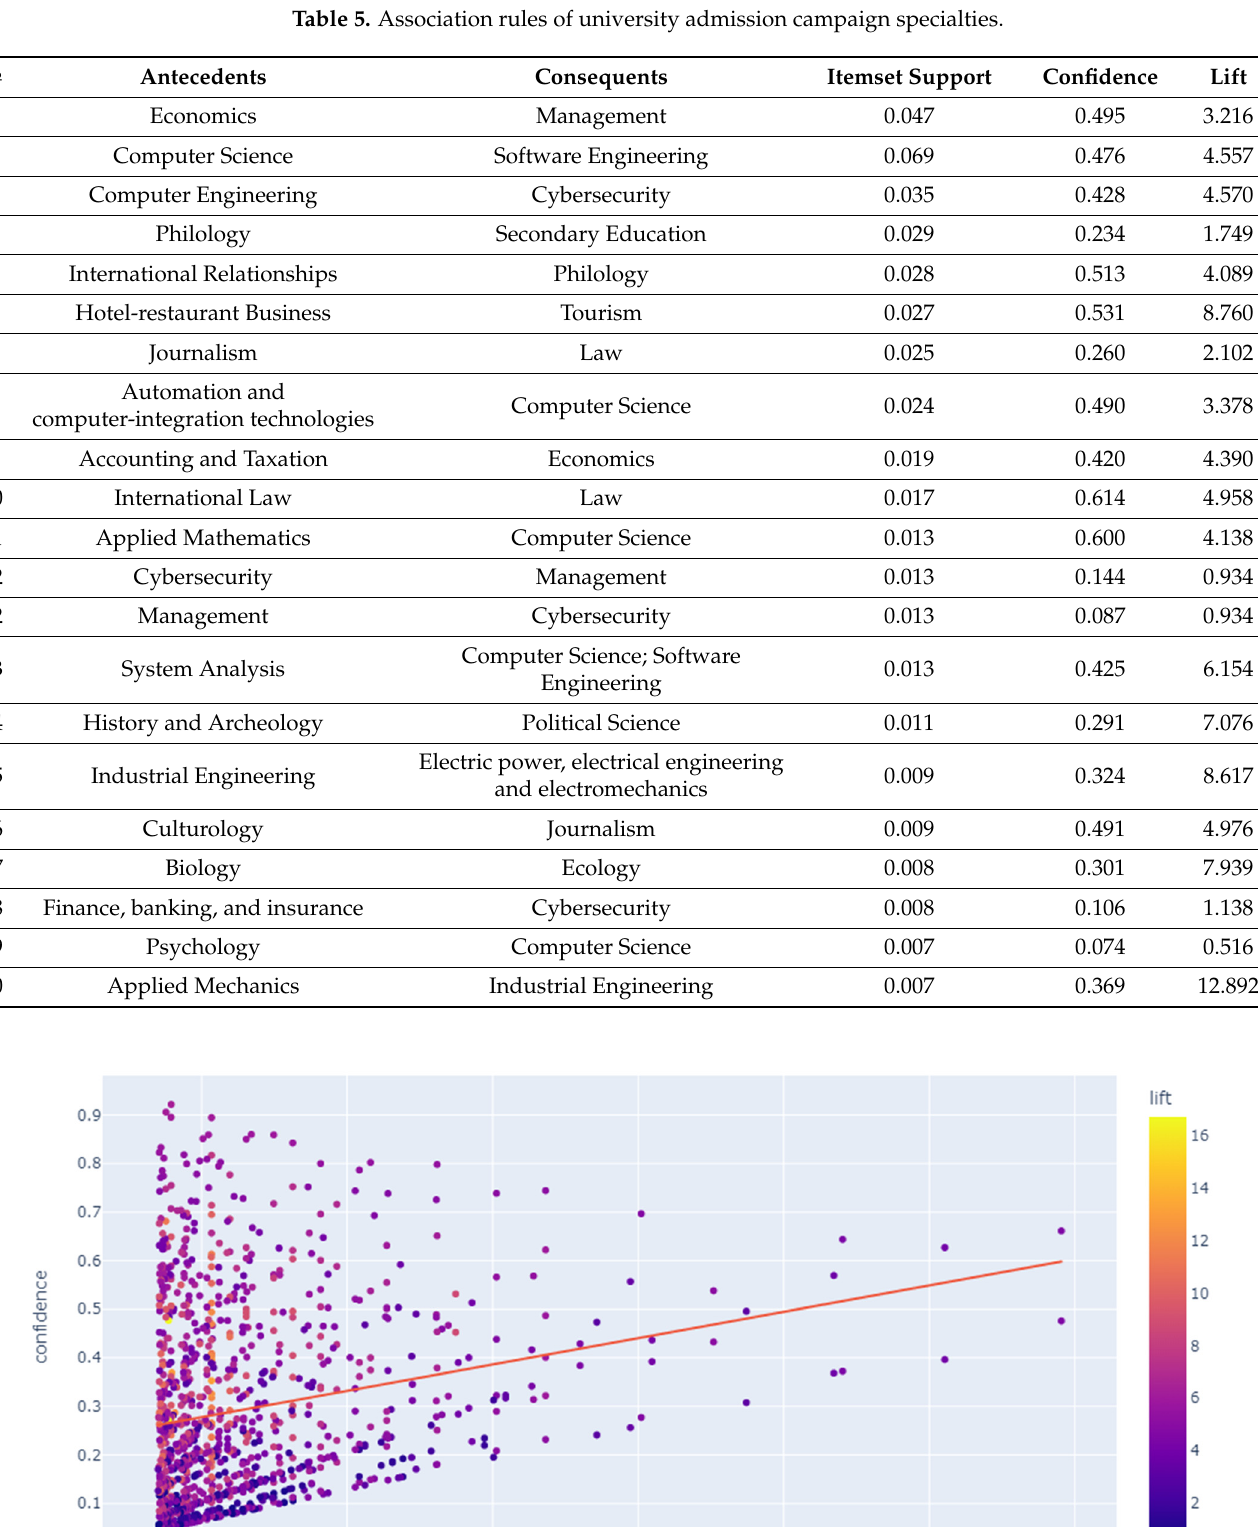
Table 5. Association rules of university admission campaign specialties.